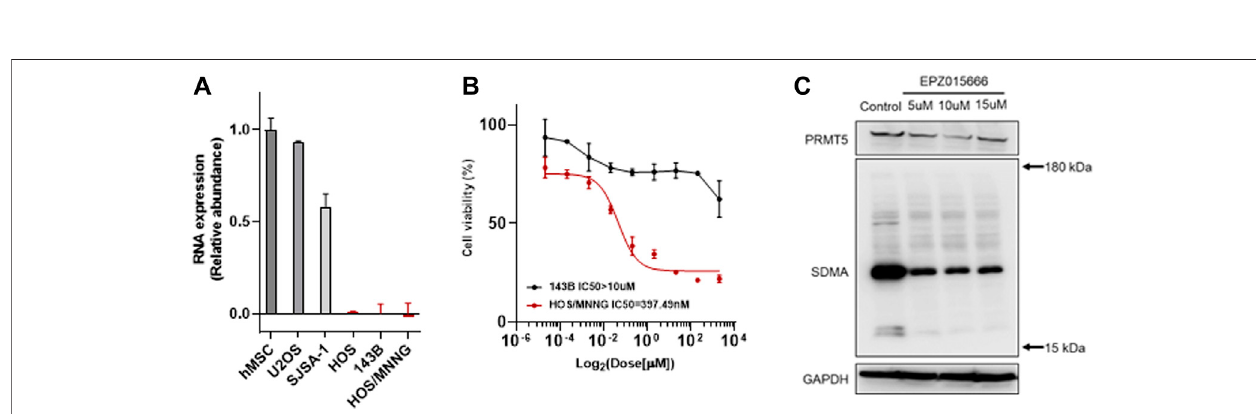
FIGURE 2 | EPZ015666 inhibits the growth of MTAP-deleted osteosarcoma. (A) Relative abundance of MTAP RNA expression in hMSCs and common osteosarcoma cell lines (U2OS, SJSA-1, HOS, 143B and HOS/MNNG) in vitro , respectively. (B) Cell viability of MTAP-deleted osteosarcoma (black and red line represents 143B and HOS/MNNG, respectively) after using a concentration gradient of EZP015666 in vitro . (C) SDMA modi fi cation reduction by treated EPZ015666 (143B) in vitro . hMSC, human mesenchymal stem cell; IC50, half maximal inhibitory concentration; SDMA, symmetric di-methyl-arginine.